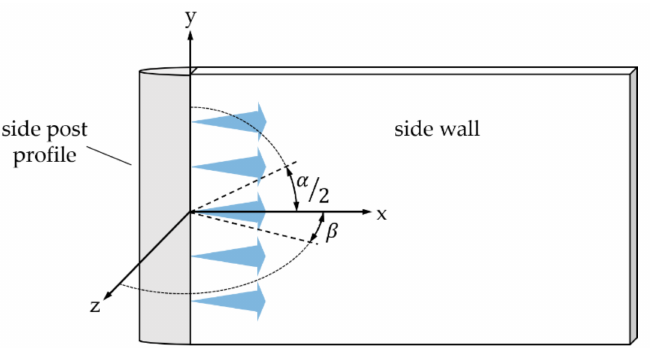
Figure 11. Three-dimensional reference system for the wall jets blowing out of the side post profile— schematic